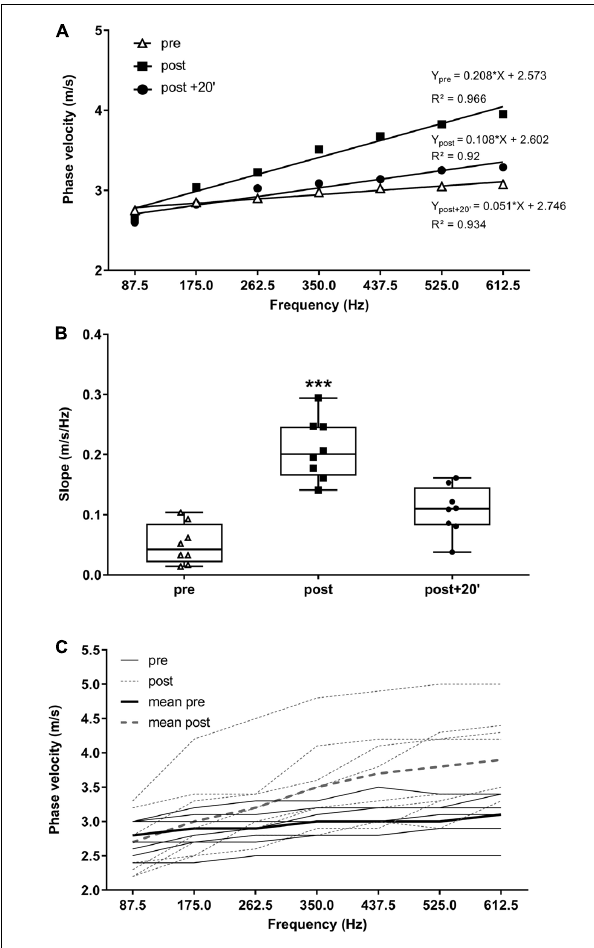
FIGURE 3 | Phase velocity (m/s) along the fibers as a function of frequency (Hz) at pre, post, and post + 20’. Regressions equations and correlation coefficients are presented for each relationship (A) . Mean of the slopes for each time point and individual values. Mean ± SD ( B , C, respectively). ∗∗∗ P < 0.001, significant differences from pre-exercise (pre) values.